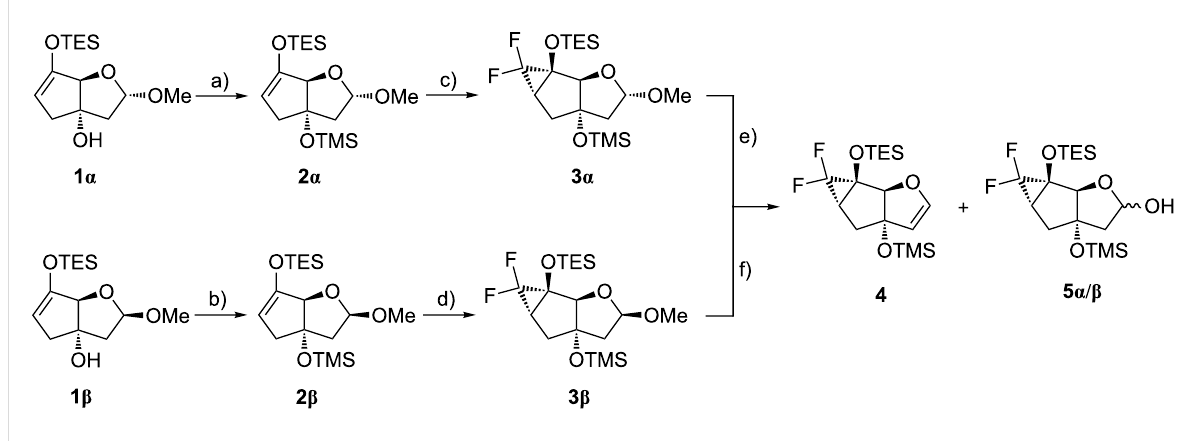
Scheme 1: Synthesis of the gem -difluorinated glycal 4 from the silyl enol ethers 1 α / β . Reagents and conditions: a) BSA, DCM, rt, 17 h, 86%; b) BSA, DCM, rt, 18 h, 88%; c) TMSCF 3 , NaI, THF, 70 °C, 2 h, 71%; d) TMSCF 3 , NaI, THF, 70 °C, 4 h, 75%; e) TMSOTf, 2,6-lutidine, DCM, 0 °C to rt, 2 h, 41% ( 4 ), 39% ( 5 α / β ); f) TMSOTf, 2,6-lutidine, DCM, 0 °C to rt, 7 h, 58% ( 4 ), 29% ( 5 α / β ).